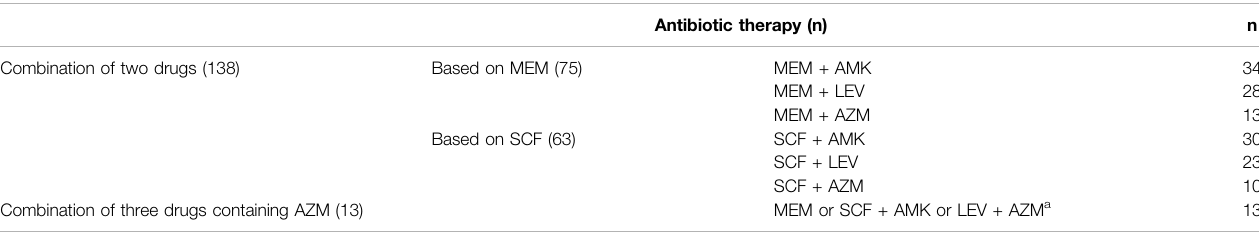
TABLE 3 | Clinical grouping of 151 cases.